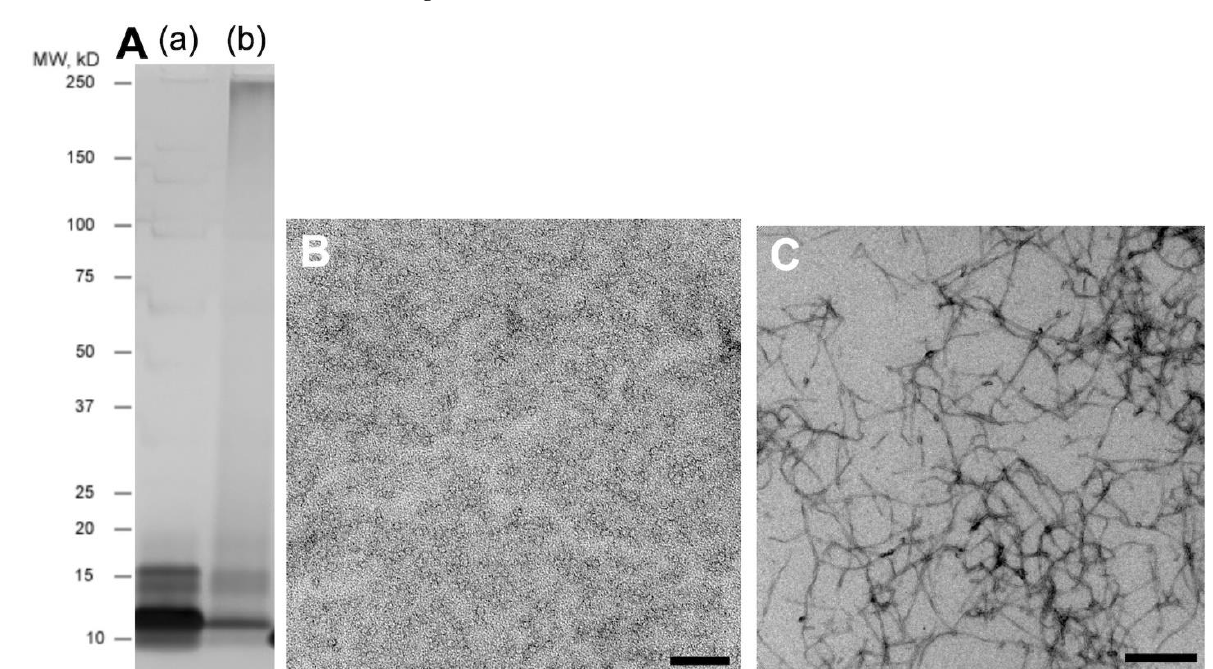
Figure 1. Fibril formation of Aβ 1 – 40 . ( A ). SDS –PAGE of Aβ 1 – 40 solution immediately after being prepared with silver staining on ice ( a ) or solution after incubation for 144 h ( b ). Fresh sample ( a ) showed strong bands at MW 10–16 kD, suggesting a low number of oligomers, especially monomers, dimers, and trimers, whereas incubated sample ( b ) showed a strong band at MW 250 kD or higher. TEM of the fresh solution showed granular structures of 9.0–13.8 nm in diameter ( B ), whereas that of the incubated solution showed a fibrous structure of approximately 25 nm in diameter ( C ). Scale bar: ( B ) 100 nm; ( C ) 500